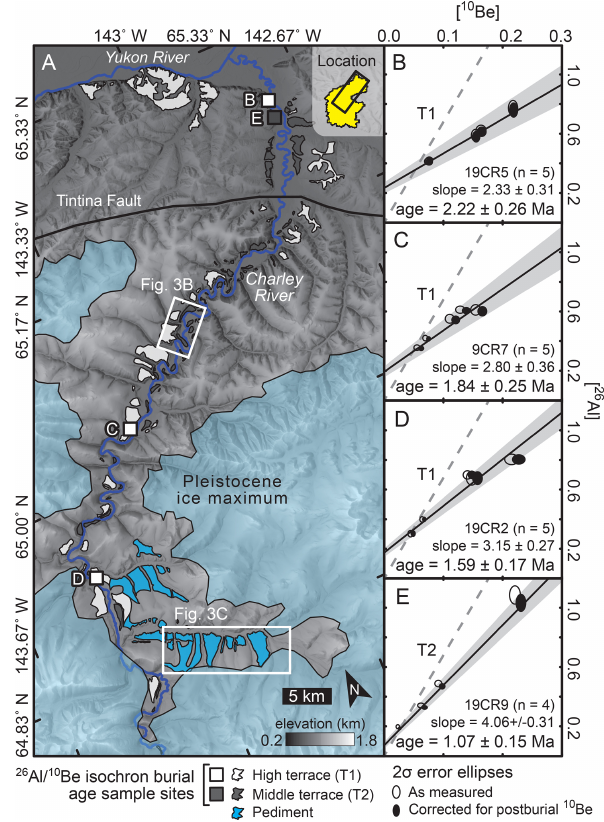
Figure 2. Charley River field area and cosmogenic results. (A) Charley River geomorphic map, terrace cosmogenic 26 Al / 10 Be isochron burial age sample sites, and Pleistocene ice maximum (Kaufman et al., 2011; Duk-Rodkin et al., 2001) rendered on the IfSAR Alaska digital elevation model (https://earthexplorer.usgs. gov/, last access: 24 October 2022). White outlined boxes in- dicate areas photographed in Fig. 3b and c. (B–E) Cosmogenic 26 Al / 10 Be isochron burial age plots for high (T1) and intermediate terraces (T2), isotope concentrations are in units of 10 6 atomsg − 1 quartz. Gray dashed line is the 26 Al / 10 Be surface production ratio and ∼ zero age, gray envelope is the 1 σ regression